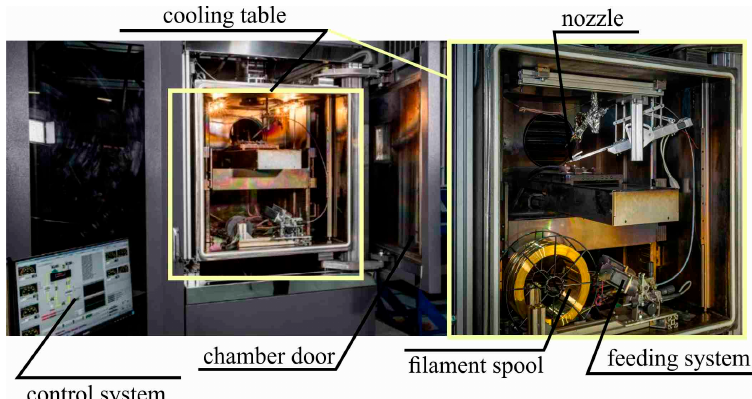
Figure 1. Additive electron beam printing setup with wire filament.